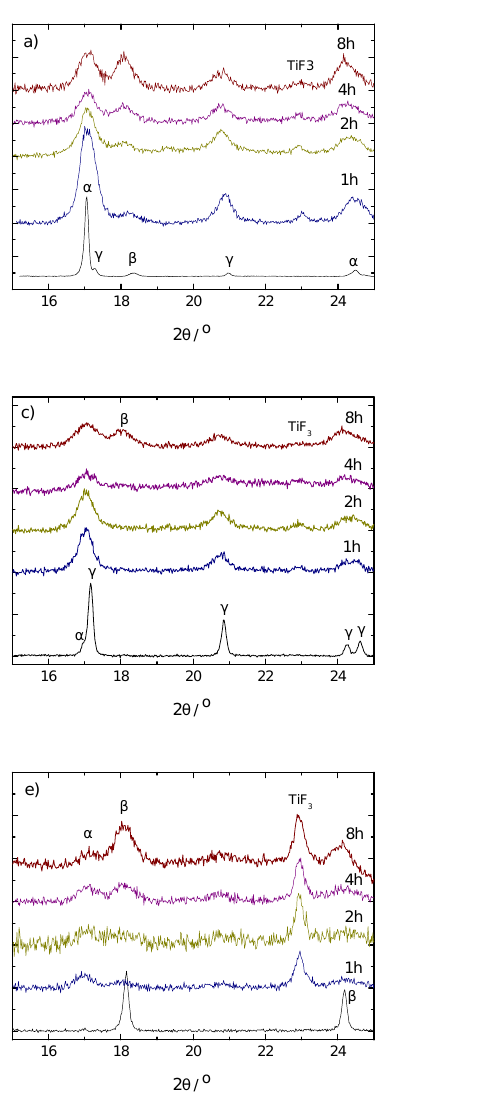
Figure 2. PXD results on ball milled α βγ (up, ( a , b )) and γ (middle, ( c , d )) with 1.6 mol% (left-hand side, ( a , c )) and 10 mol% (right-hand side, ( b , d )) of TiF 3 . Bottom: PXD results on ball milled β 64 (left-hand side, ( e )) and β 92 (right-hand side, ( f )) with 10 mol% of TiF 3 . Samples were taken from the vials after 1, 2, 4 and 8 h milling. The pattern of the as-received sample is included for